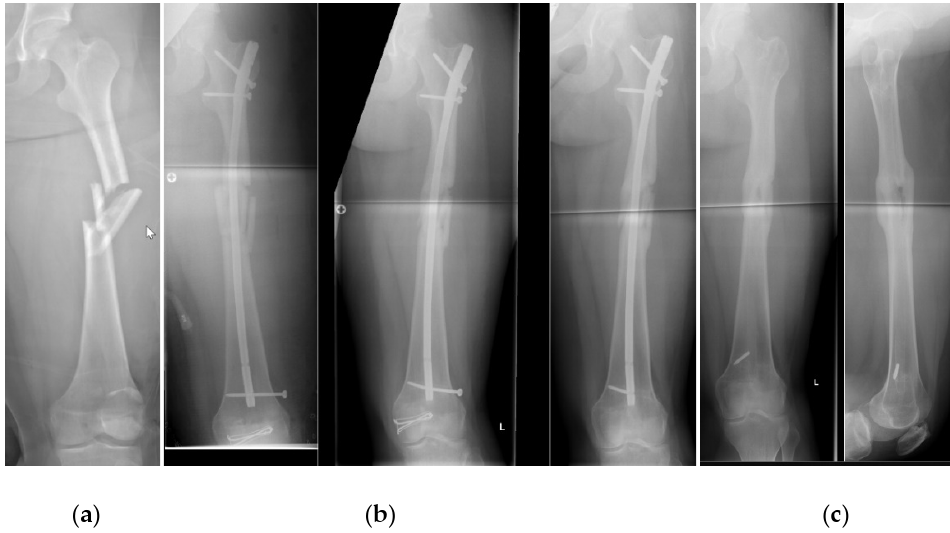
Figure 4. ( a ) Initial radiograph of a segmental fracture of the femoral shaft without cortical contact. ( b ) Same patient as in Figure 4a, four weeks after fixation with an ALFN. The position of the femoral neck screw was tolerated as it did not disturb the patient clinically. Only one distal locking screw was used which could have been advanced further. ( c ) Now after removal of the ALFN. Note the medial fragment of the distal locking screw, which was tolerated.